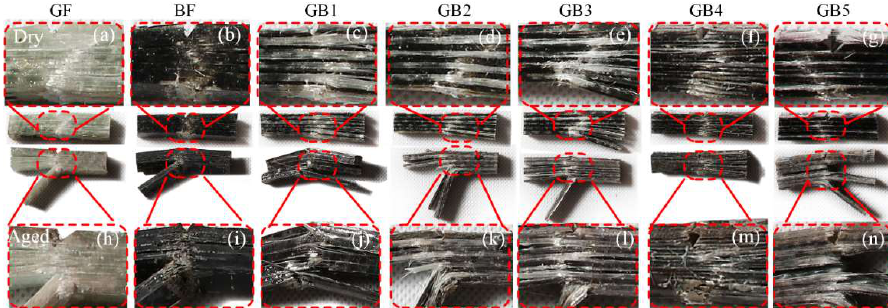
Figure 12. Photographs of impact fractured specimens in dry ( a ) GF ( b ) BF ( c ) GB1 ( d ) GB2 ( e ) GB3